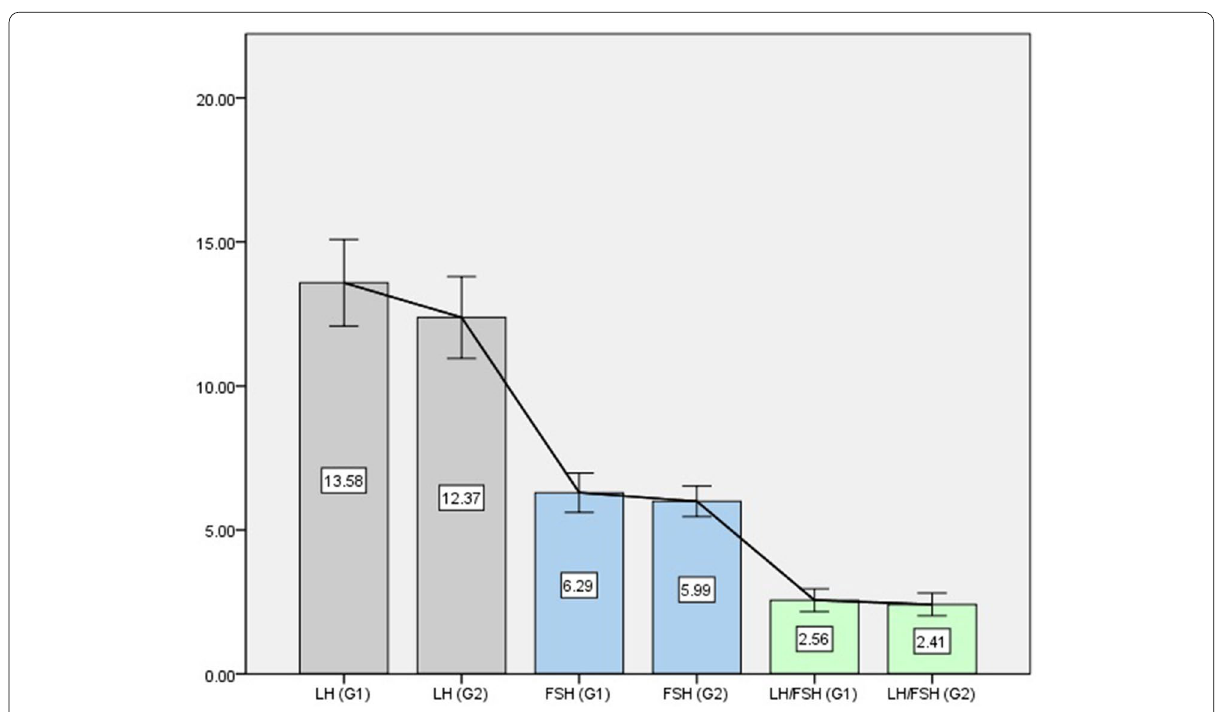
Fig. 1 Linear interpolation results in discontinuities of